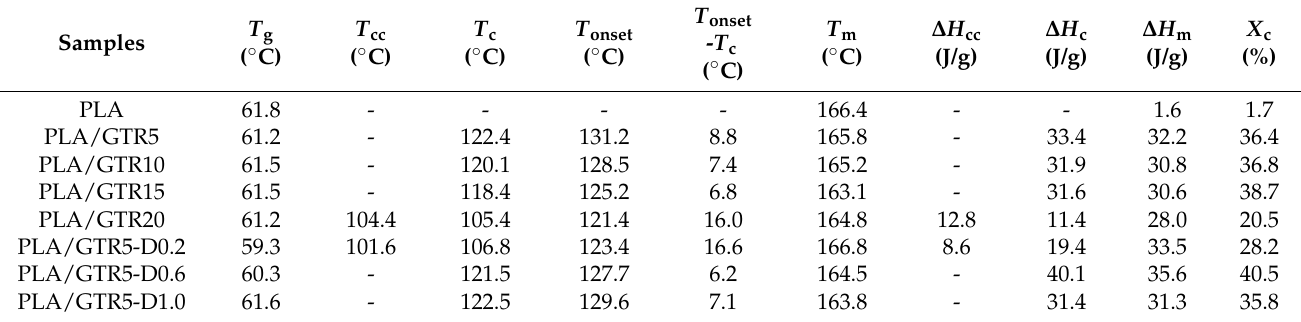
Figure 6. DSC curves of neat the PLA, PLA/GTR blends with or without DCP: ( a ) Crystallization. ( b ) Melting. Table 1. Crystallization parameters of the PLA and PLA/GTR blends.